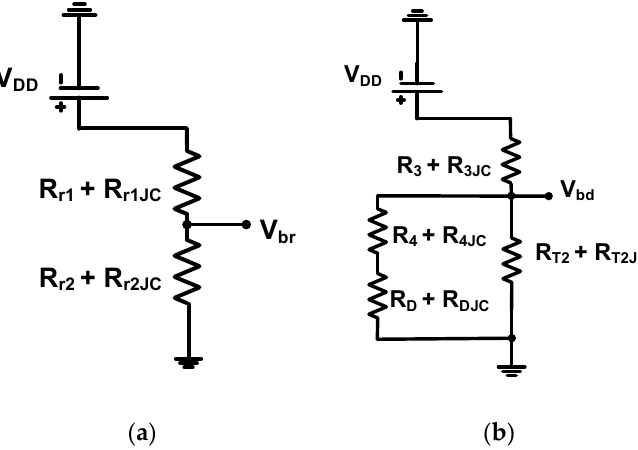
Figure 3. DC Operating mechanisms of the ( a ) resistor divider and ( b ) diode expander architecture.